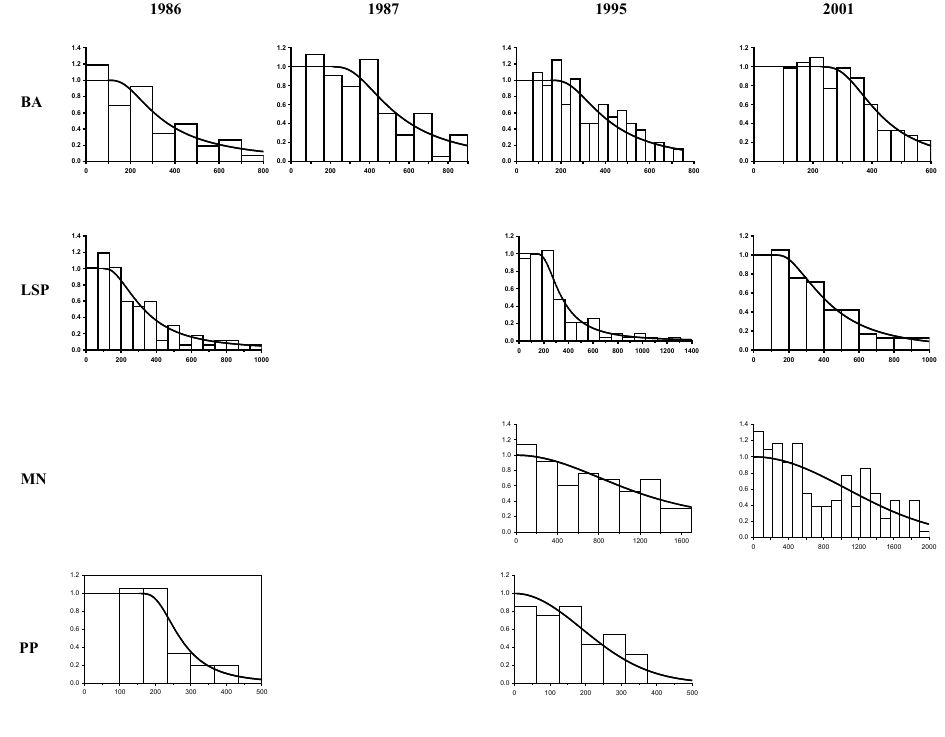
Fig. 3. Perpendicular distance functions for minke whales (BA), Lagenorhynchus spp. dolphins (LSP), hump - back whales (MN) and harbour porpoises (PP). The line shows the fit of the model to the